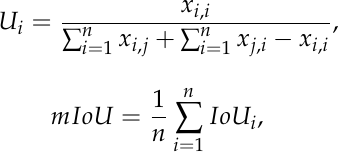
ISPRS Vaihingen dataset